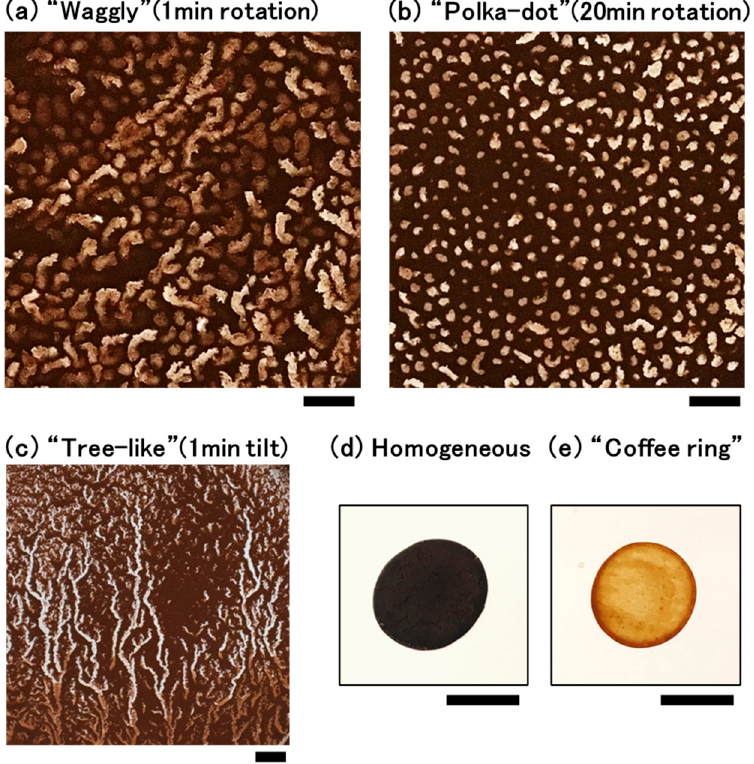
Figure 2. Generation of various characteristic patterns from a drying solution containing coffee powder under different conditions. The scale bars are 10 mm. ( a ) A waggly pattern with many wavy shapes formed when the paper dish was tilted while stationary for 10 s and then rotated for 1 min at a fixed angle of 45° (see Figure 1b). After the rotation, the dish was stood still horizontally for 24 h. The light brown and dark brown parts indicate water-rich and powder-rich regions, respectively. ( b ) Polka-dot pattern with many mini-circles generated from the coffee solution, with tilting without rotation for 10 s and then rotation for 20 min. After the rotation, the dish was stood still horizontally for 24 h. ( c ) Tree-like pattern caused by the downward flow of coffee solution when the plate was tilted at a fixed angle of 45° for 1 min without rotation, the dish was stood still horizontally for 24 h. ( d ) Homogeneous pattern formed by drying the coffee solution containing the powder, i.e., essentially the same solution as in a–c. ( e ) Usual so-called coffee-ring formed by drying the filtered coffee solution with almost no grained powder.